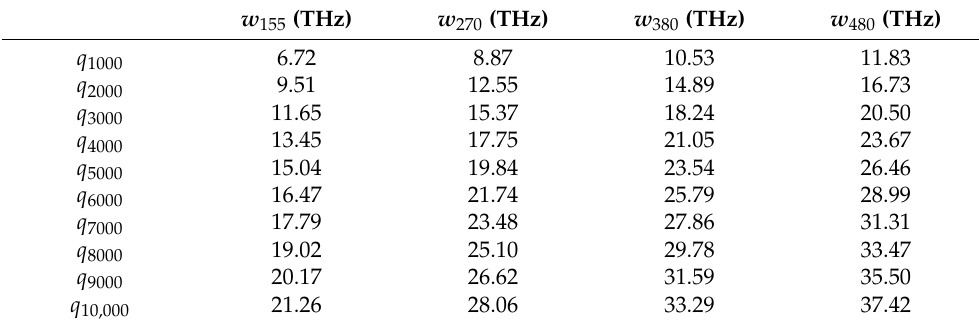
Table 8. Maximum of the plasmon peak for selected momenta at N 2 D = 4.0 × 10 12 cm − 2 .